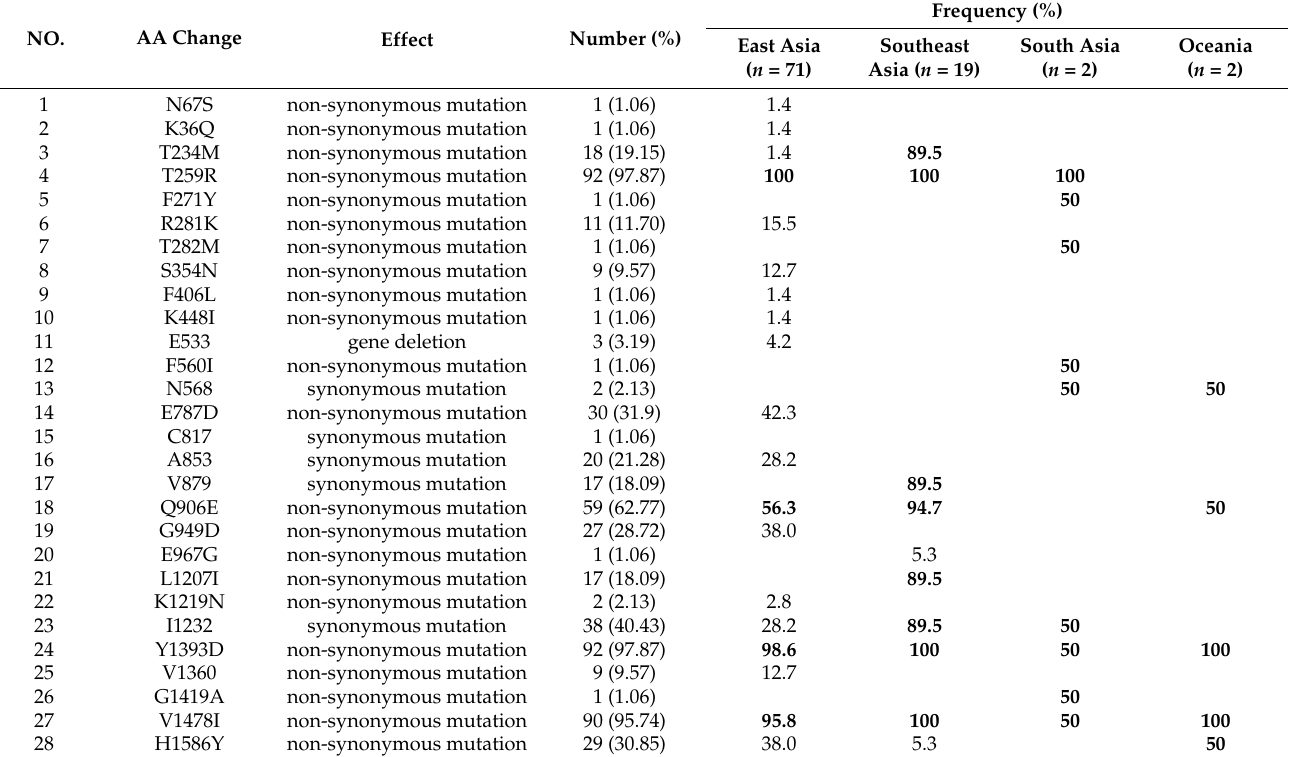
Table 2. The prevalence of pvmrp1 gene substitution in 94 parasite